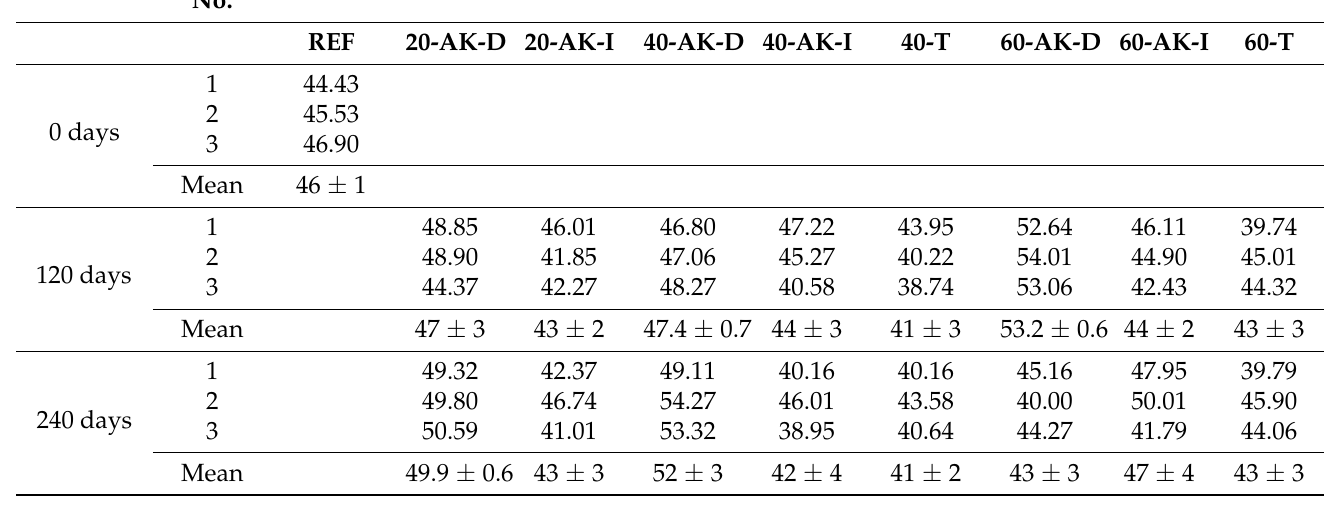
Table 8. Results of short-beam tests performed on GFRP rebars exposed to direct (AK-D) and indirect (AK-I) immersion in the alkaline solution, and to pure thermal aging as well (T). Results are also provided for unaged reference rebars (REF).